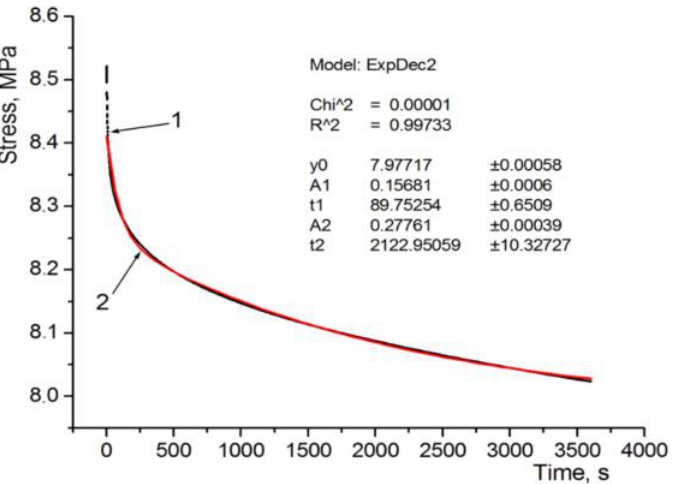
Figure 8. Approximation of the relaxation curve for sample E: 1—from the experiment; 2— relaxation function.